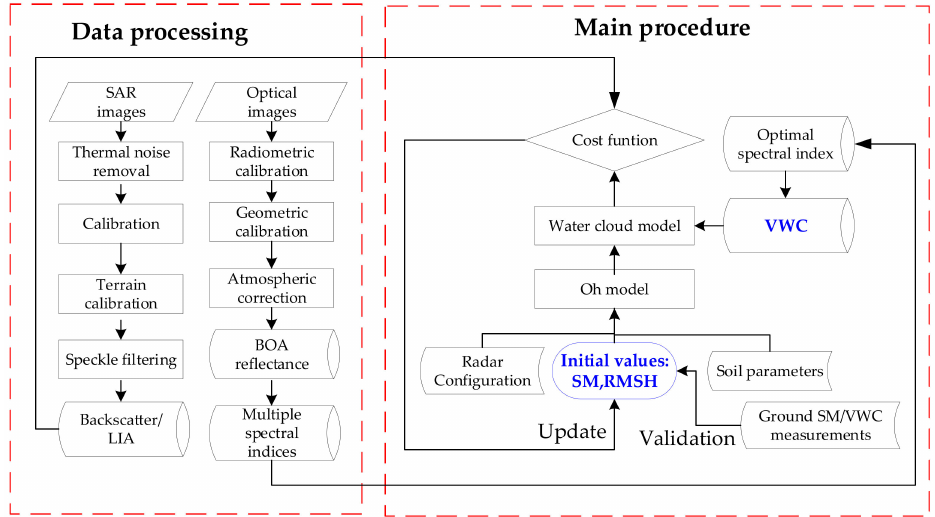
Figure 1. Flowchart of the soil moisture retrieval algorithm. The processed Sentinel-2 multispectral images are used to compute various NDVIs and NDWIs and hence to fit an empirical relations with VWC for the WCM input, while the processed Sentinel-1 synthetic aperture radar (SAR) images and coupled forward model are used to construct the cost function. The shu ffl ed-complex evolution University of Arizona (SCE-UA) algorithm [74–76] is used for minimizing the cost function and searching for the optimal solutions of soil moisture and surface